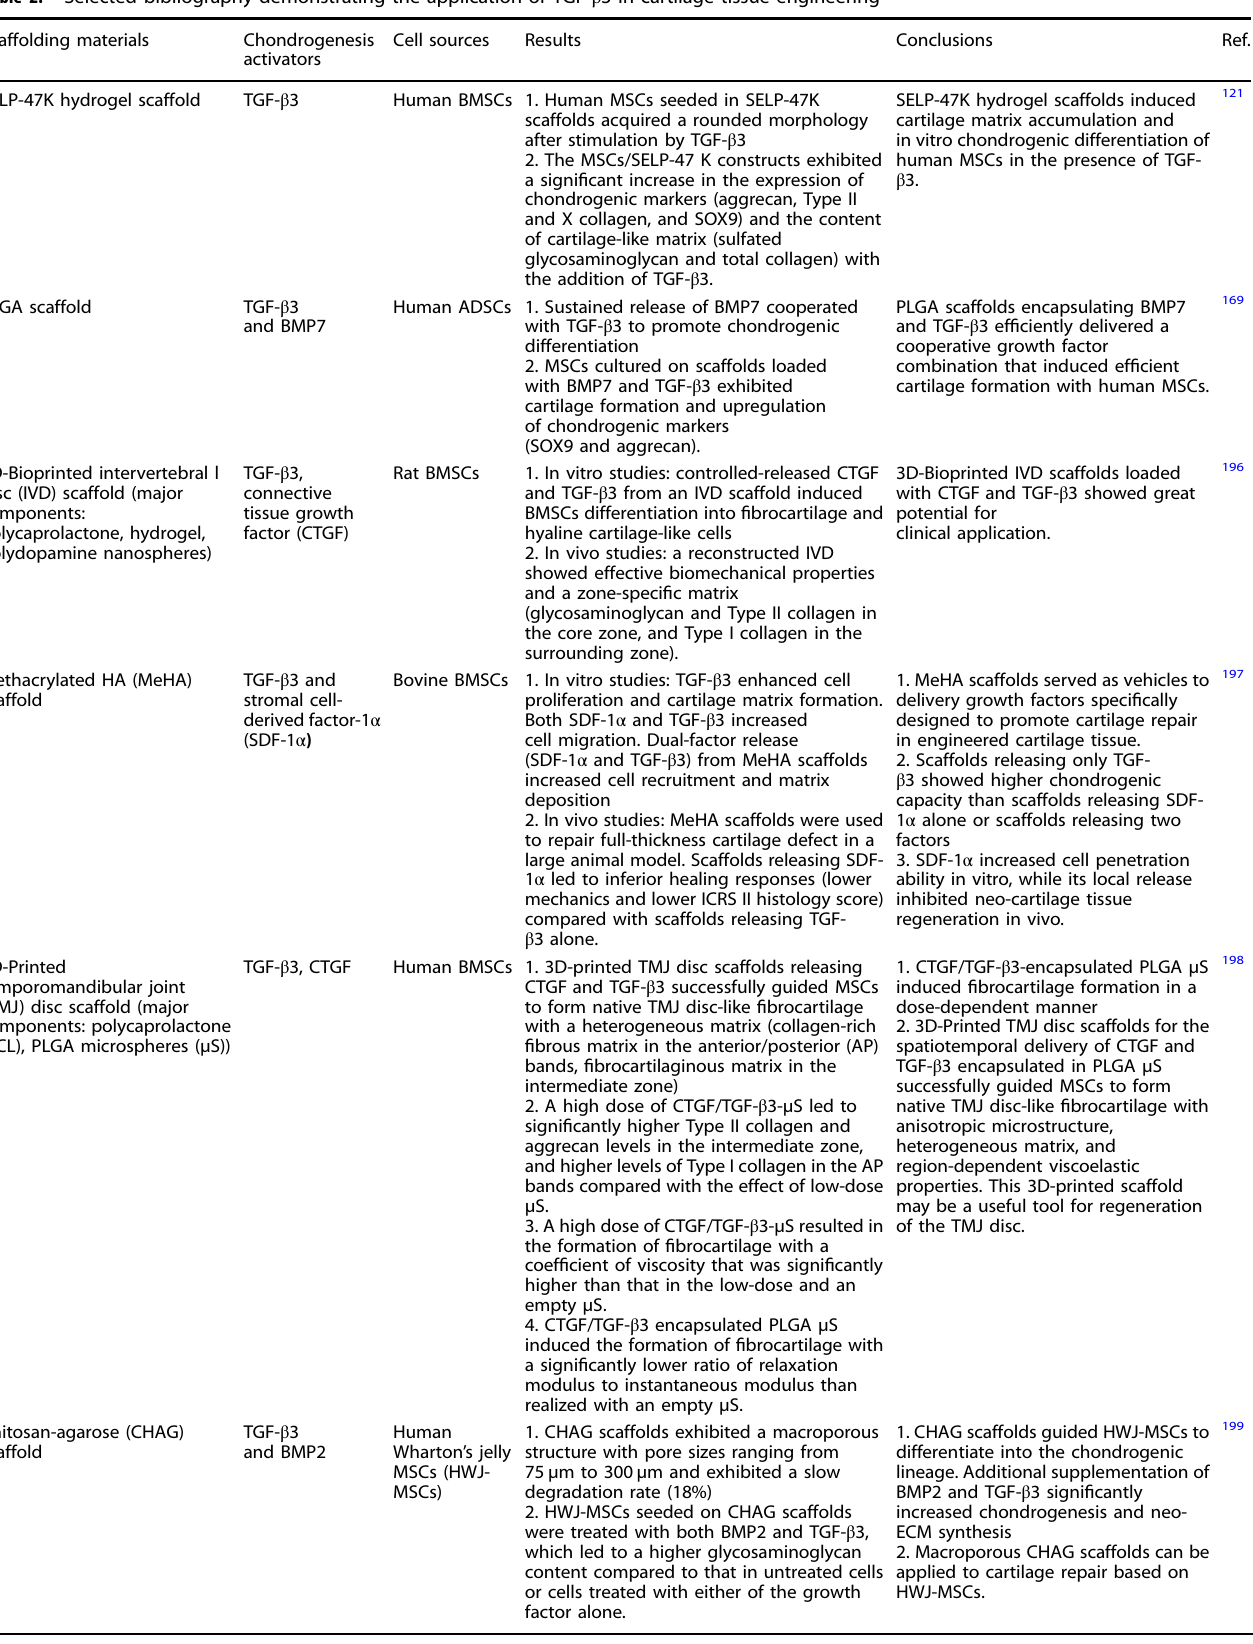
Table 2. Selected bibliography demonstrating the application of TGF- β 3 in cartilage tissue engineering Scaffolding